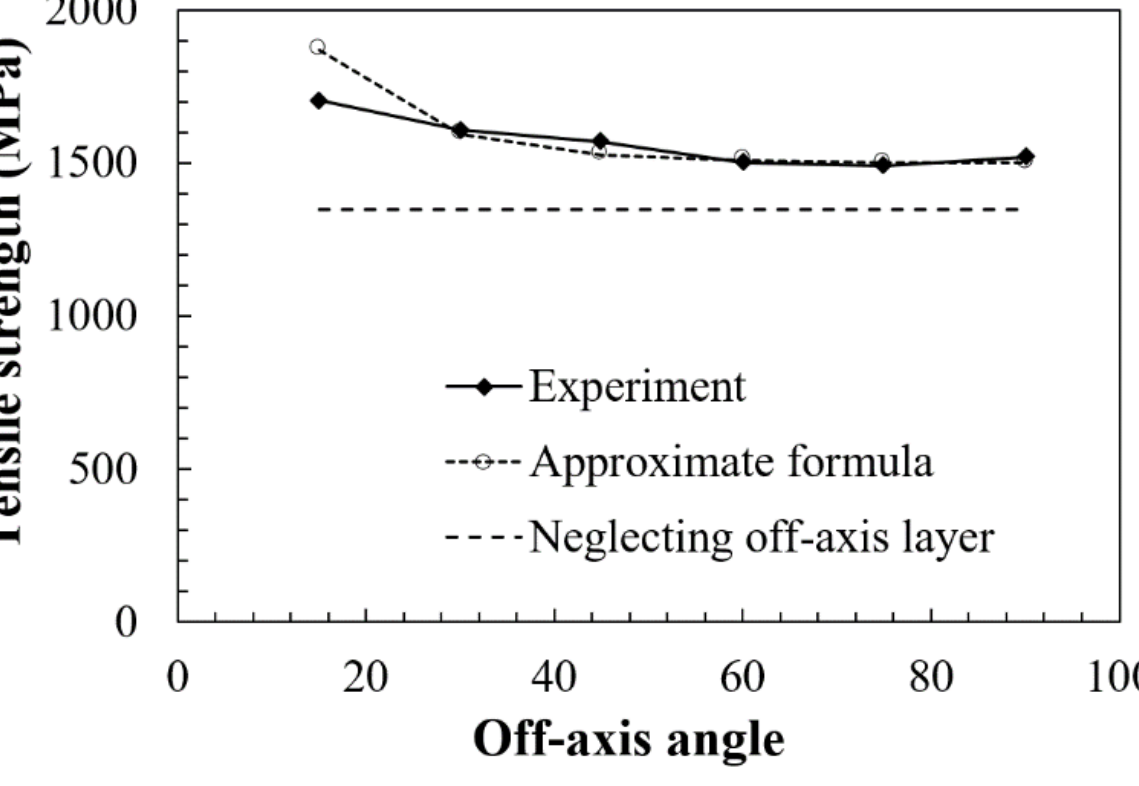
Figure 3. Relation of the failure strength of the [0/ θ ]2s laminate with an off-axis angle. According to the classical lamination theory [27], the in-plane off-axis stiffness of a unidirectional lamina is easily calculated using the in-plane stiffness of a unidirectional ply. The off-axis stiffness constants S ij ( i , j = 1, 2, 6) of one lamina can be calculated using